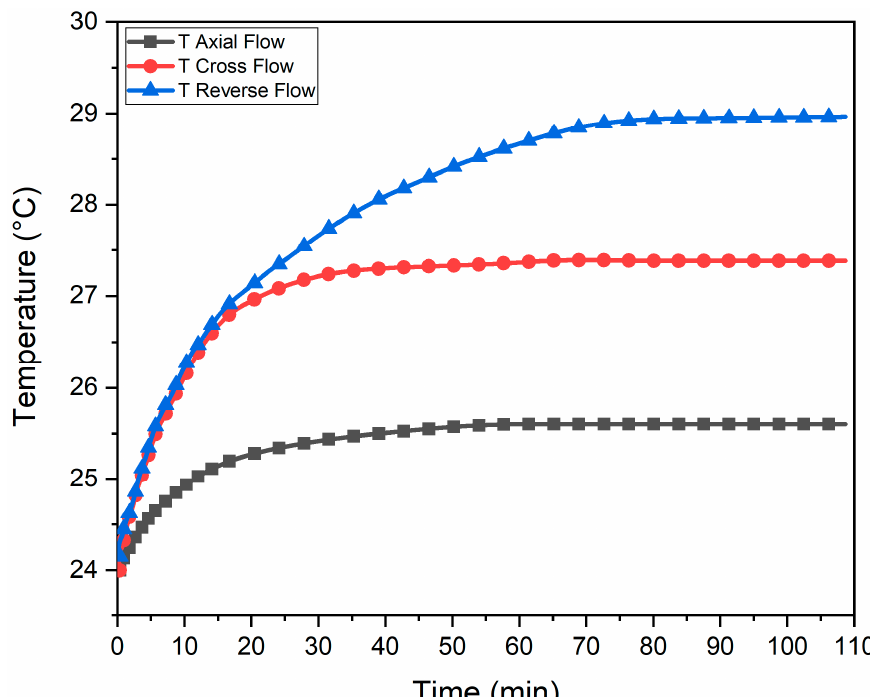
Figure 16. Cavity configuration comparison at a power level of 10 W.